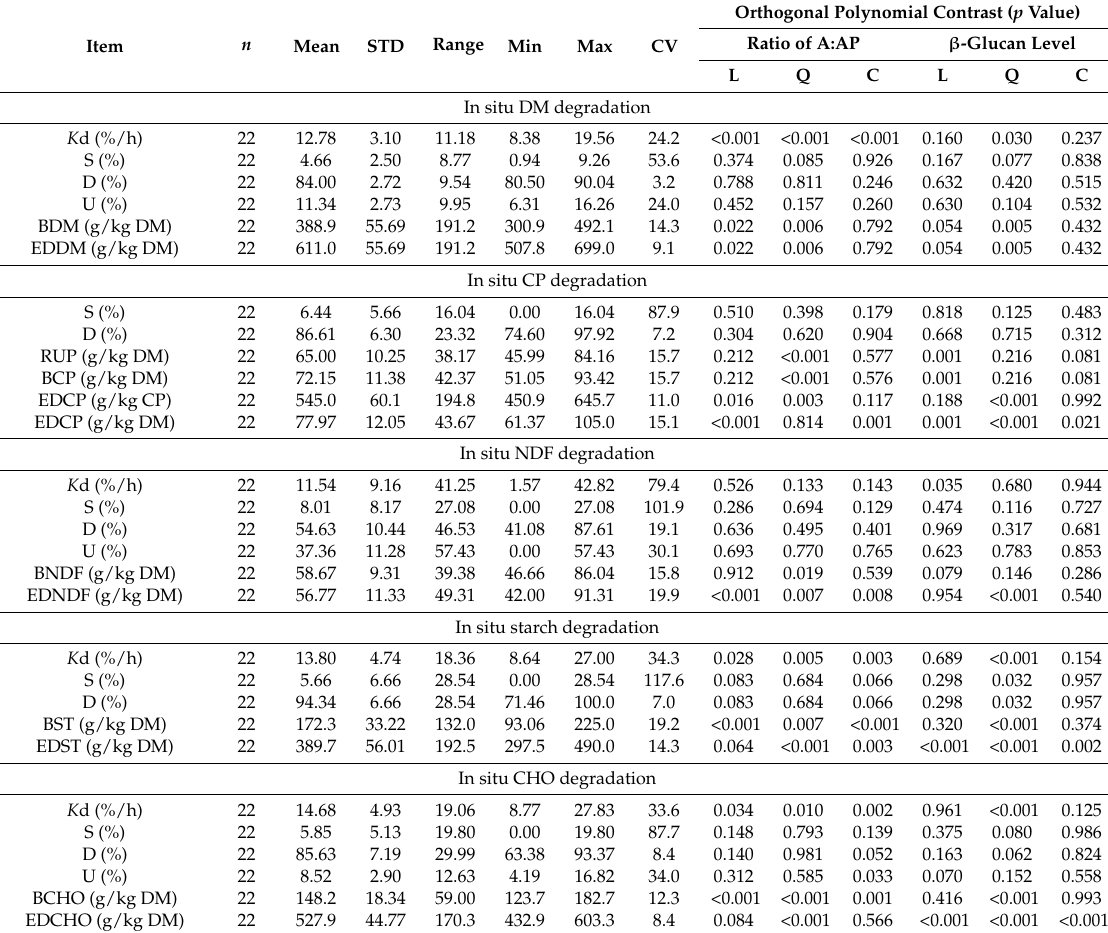
Table 3. Curve-linear response of nutrient biodegradation and bioavailability to altered CHO macromolecular structure traits in CDC hulless barley